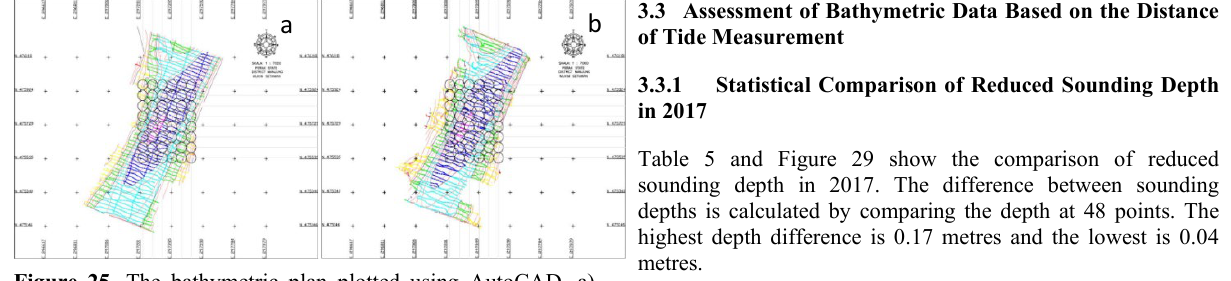
Figure 25. The bathymetric plan plotted using AutoCAD. a) The bathymetric plan in 2017 and b) the bathymetric plan in 2018